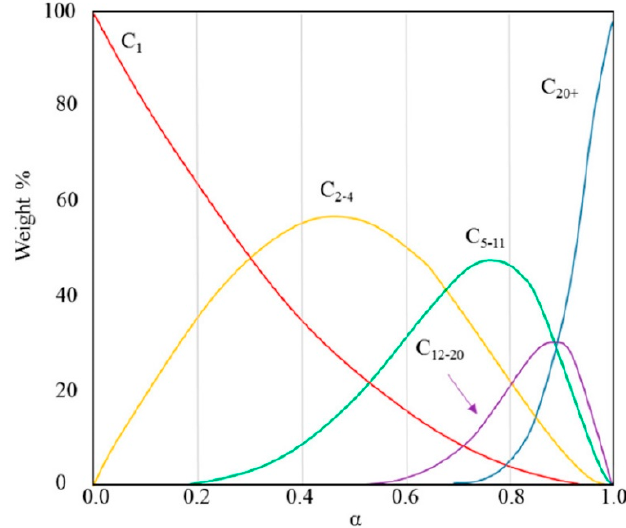
Figure 1. Dependence of quantity and type of products on the probability of chain growth [26].